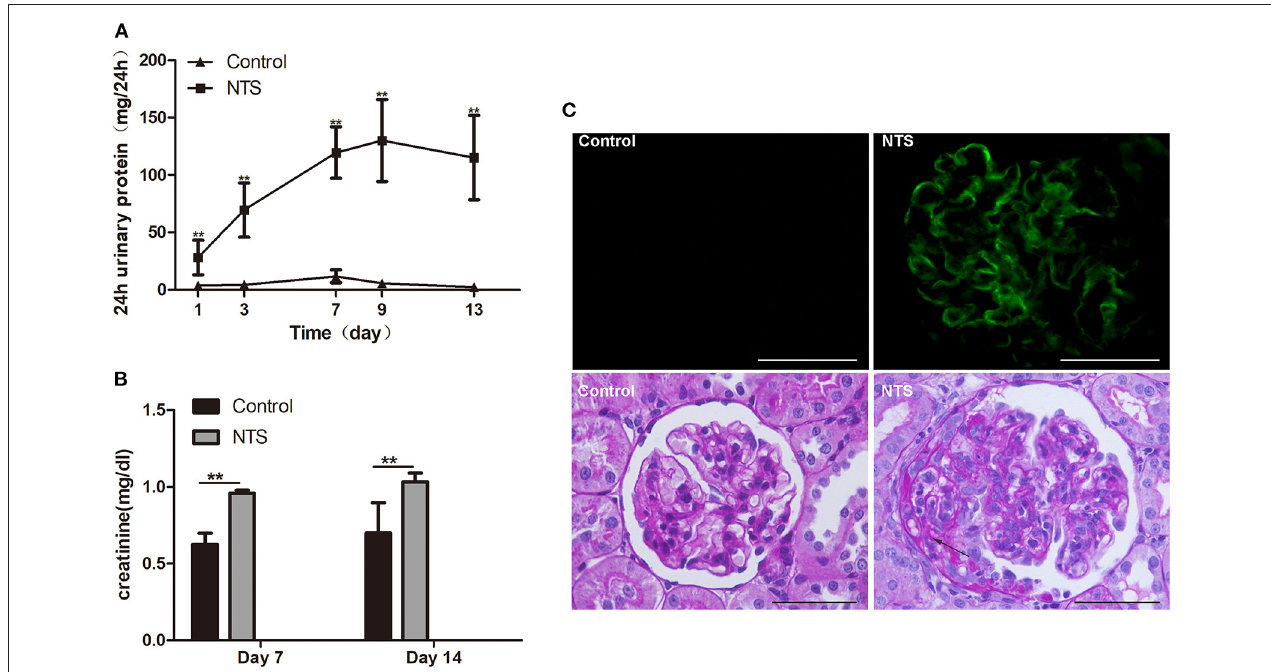
FIGURE 2 | Clinicopathologically characteristics of rat model of anti-GBM nephritis. (A) 24-h urinary protein levels in rats after NTS injection and control ( n = 5 per group). (B) Serum creatinine concentration of NTS and control rats at day 7 and day 14 ( n = 5 per group). (C) Immunofluorescence staining of goat anti-rabbit IgG in kidney of NTS rats, showing strong linear deposition of IgG along GBM; and Periodic acid–Schiff staining of kidney sections at day 14, showing crescent formation (arrows) in glomeruli of NTS rats. ** P < 0.01; Scale bars, 50 µ